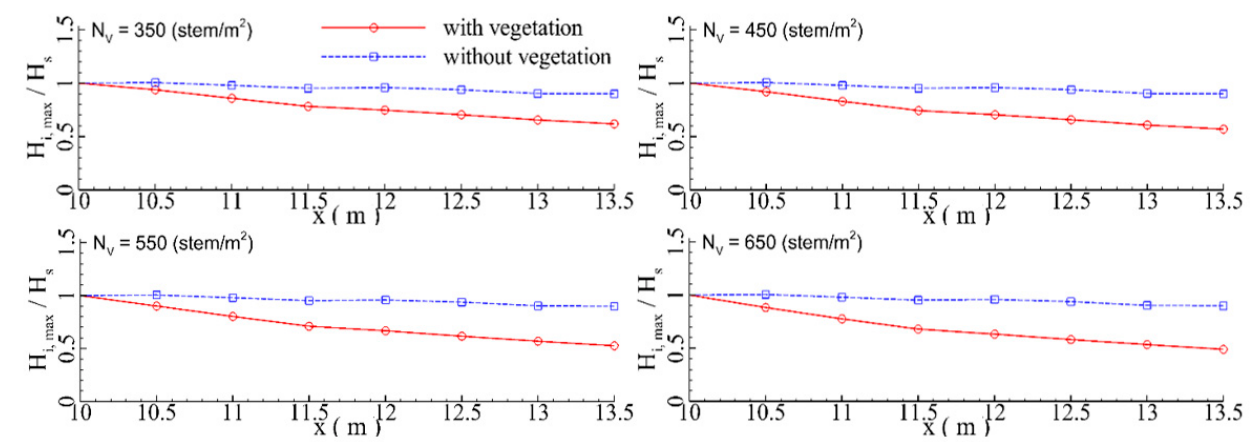
Figure 25. Spatial distributions of local maximum wave height under different vegetation densities.